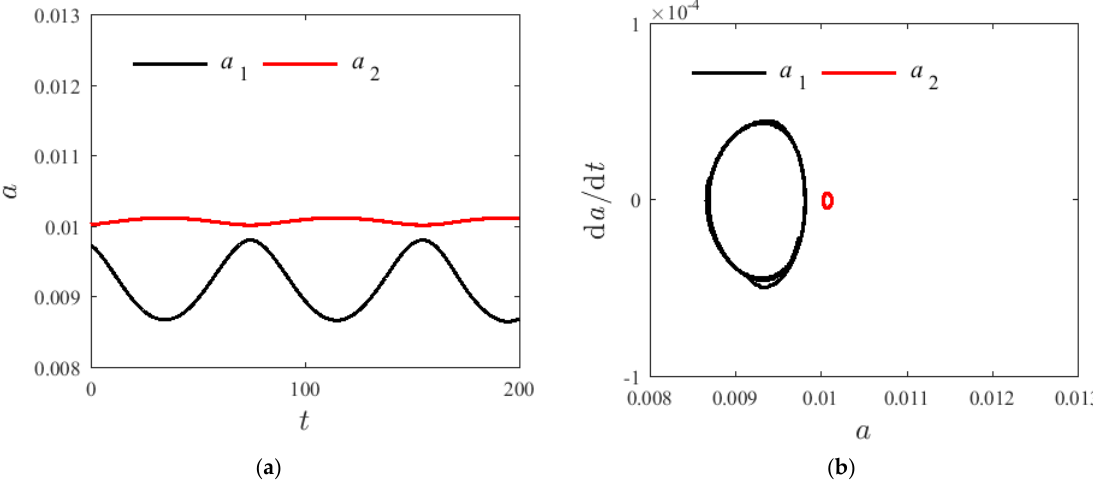
Figure 7. Internal resonances response curves v = 100 m/s; ( a ) time process diagram, ( b ) phase diagrams.